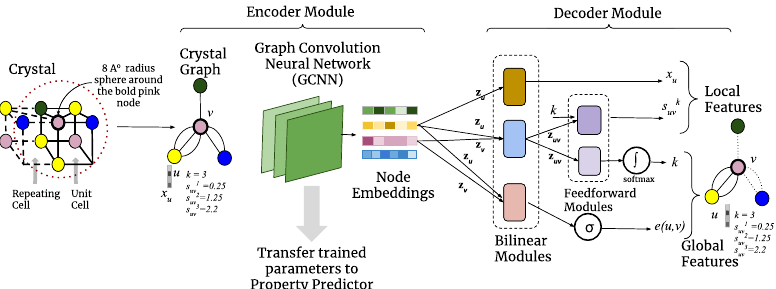
Fig. 2 Architecture of the Crystal Auto Encoder (CrysAE) module. It comprises a multilayer graph convolution network as the encoder and a corresponding decoder module for reconstructing different local and global